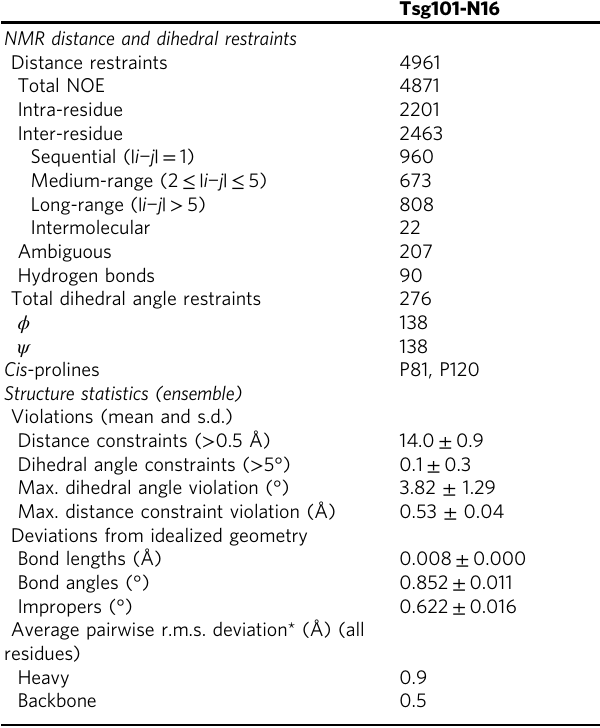
(Fig. 4e, f, Supplementary Fig. 8). This contrasts with the Ub- binding pocket perturbation pro fi le, which indicated N16 inter- fered throughout the pocket resulting in a signi fi cantly lower Tsg101 Ub binding af fi nity in the presence of N16 (Fig. 4g, h, Supplementary Fig. 9).